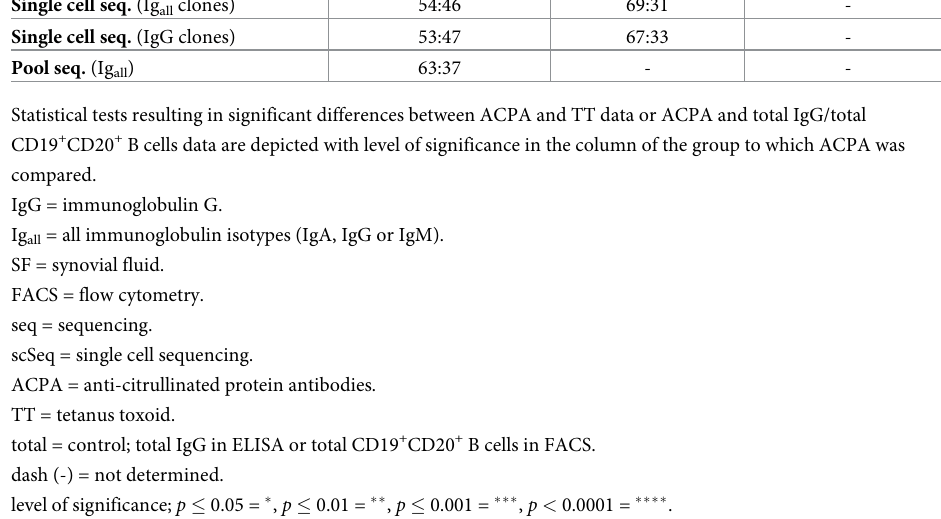
total CD19 + CD20 + B cells. In six out of these seven donors, citrullinated antigen-binding B